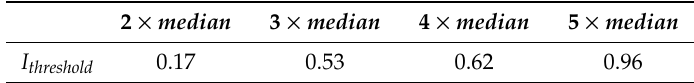
Table 2. Evaluation of the threshold selection for cutting long